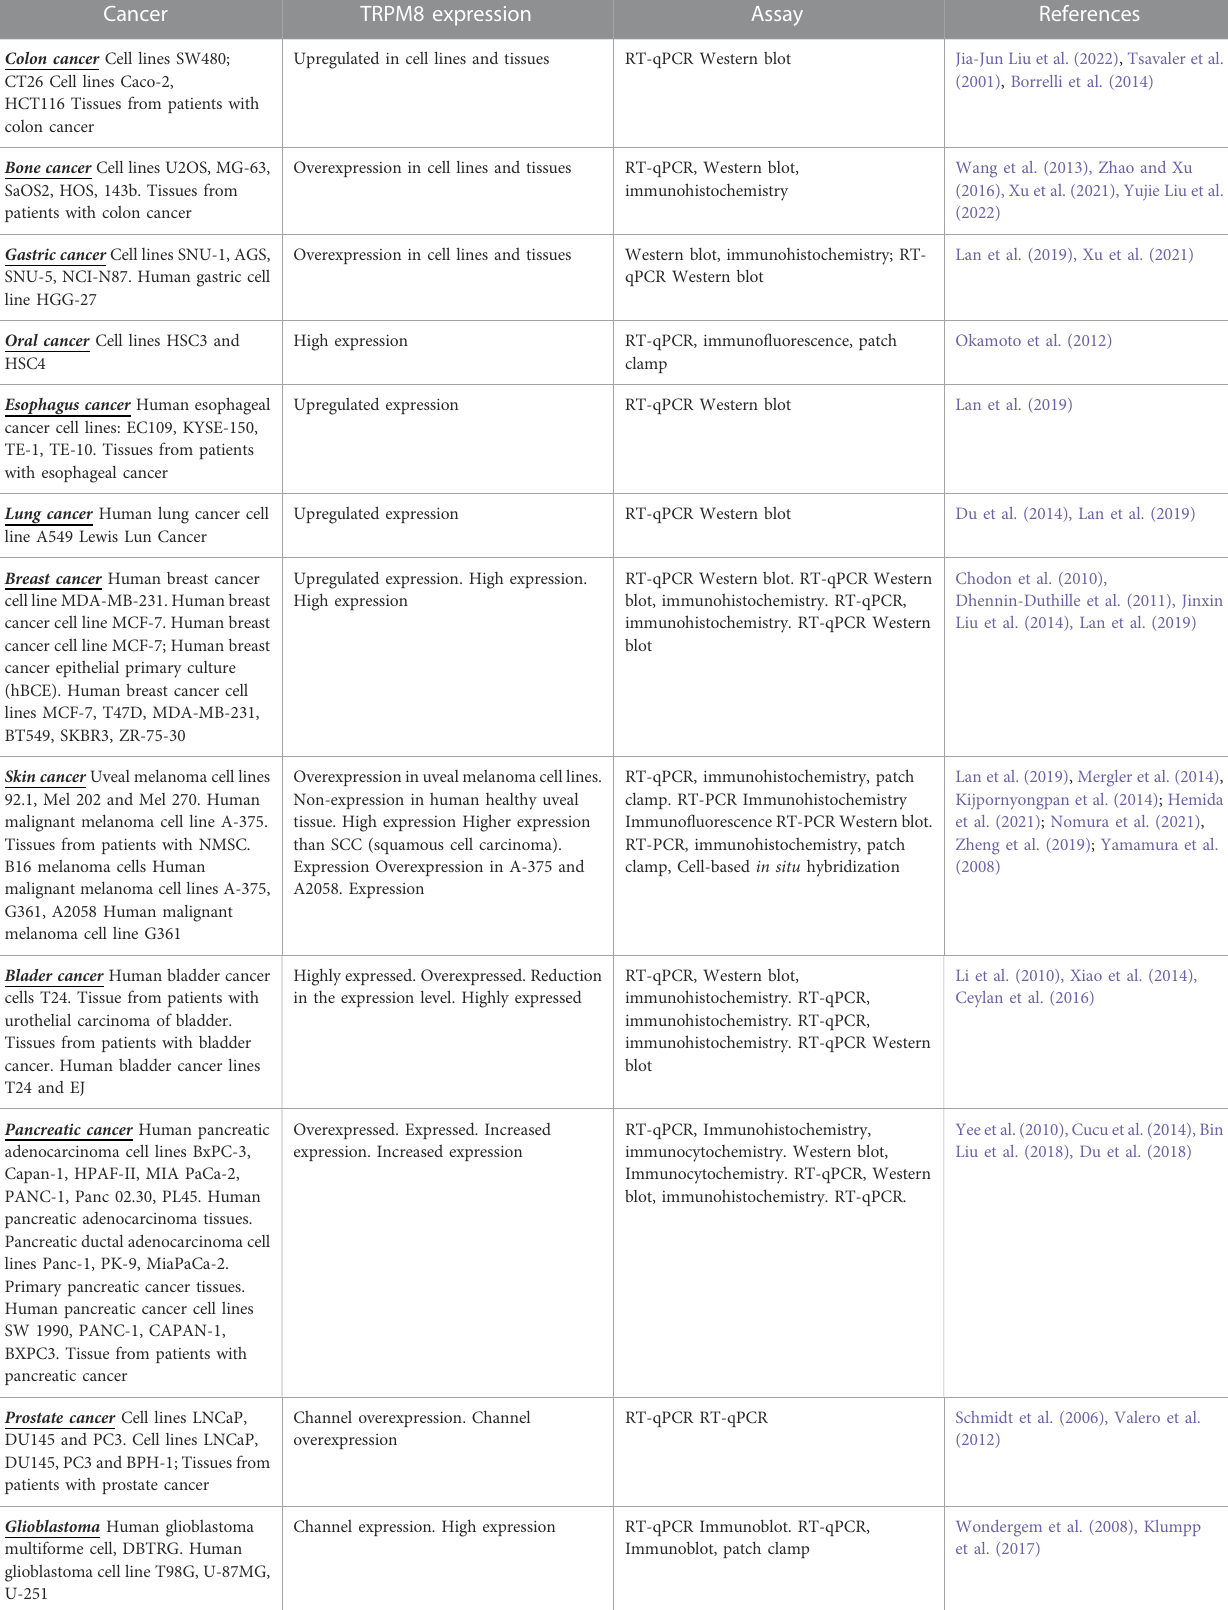
TABLE 1 Expression of TRPM8 in diverse cell cancer lines and tissues from